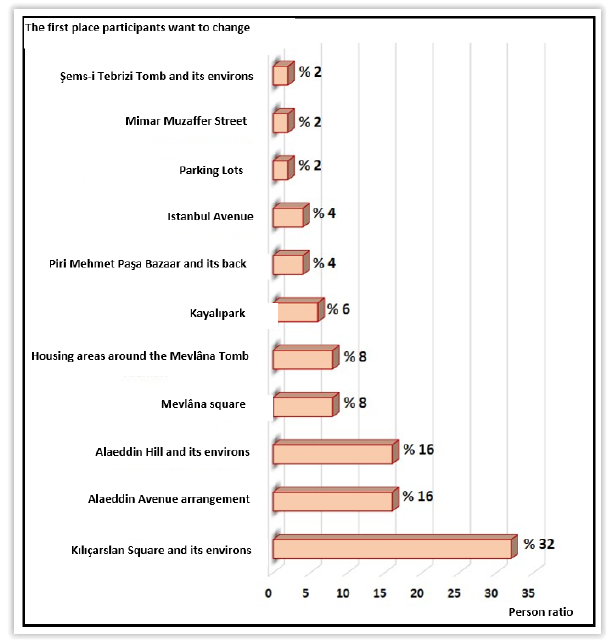
Figure 18 The first area that the participants would change if authorized (Ünal,